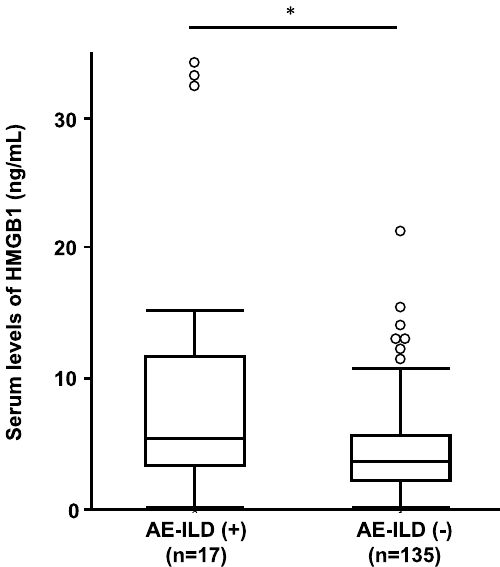
Figure 1. Baseline levels of serum HMGB1. Serum levels of HMGB1 in patients with postoperative acute exacerbation of interstitial lung disease (AE-ILD) were higher than those in patients without (median [IQR]: 5.39 [3.29–11.70] ng/mL vs. 3.55 [2.07–5.62] ng/mL, P = 0.031). Boxes represent the 25th to 75th percentiles; solid lines within the boxes show the median values; whiskers represent the 10th and 90th percentiles; the circles represent outliers. * P < 0.05 using the Mann–Whitney U test. IQR, interquartile range.